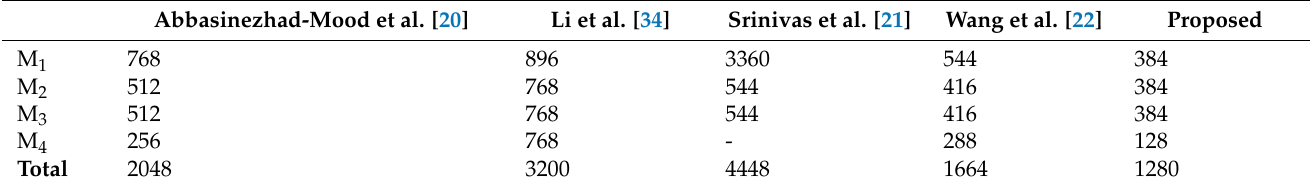
Table 5. Communication Costs Comparison.